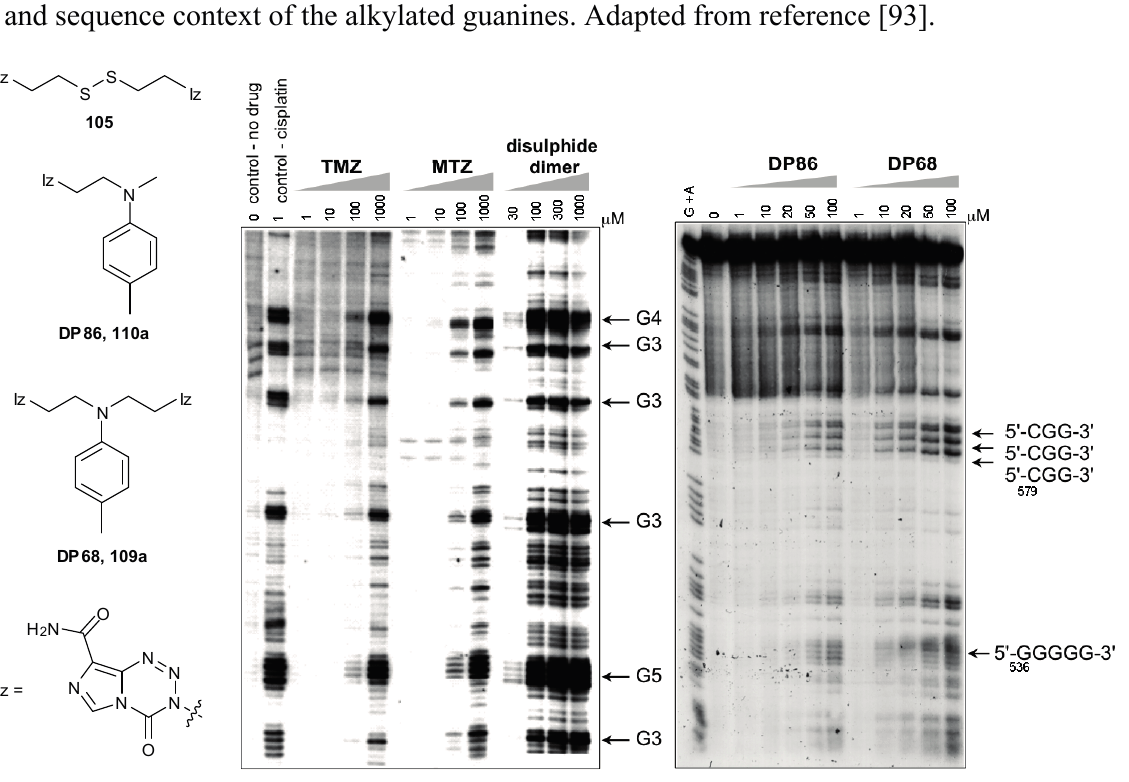
Figure 16. ( Left ) Comparison of reaction of TMZ, MTZ and a disulphide-linked dimer 105 with DNA showing the enhanced reactivity of the episulphonium prodrug, sites of DNA alkylation detected by the Taq DNA polymerase stop method (adapted from reference [90]); ( Right ) Reaction of Aziridinium Prodrugs (DP86 and DP68, 107a and 108a ) showing the increased reactivity of the bisimidazotetrazine. Sites of G N 7 alkylation on the upper strand of pBR322 DNA detected by the piperidine cleavage method. Arrows indicate the position and sequence context of the alkylated guanines. Adapted from reference